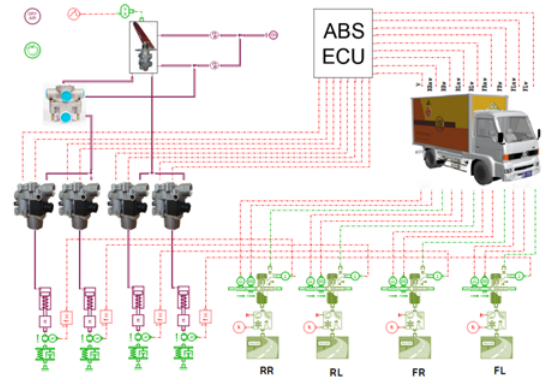
Figure 7. Simulation model topology. Electronics 2020 , 9 , 318